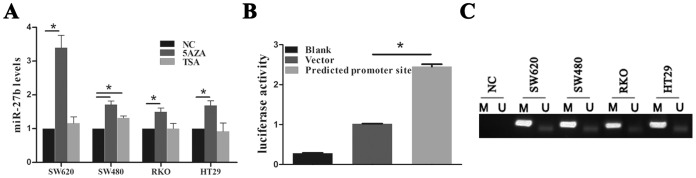
DNA hypermethylation is associated with decreased miR-27b expression.(A) The levels of miR-27b expression in colorectal cancer (CRC) cell lines were determined by qPCR after treatment with 5AZA or TSA for 3 days. (B) Results of luciferase activity assays following transfection with the predicted miR-27b promoter normalized to pRL-TK Renilla luciferase. (C) MSP analysis of the miR-27b CpG island in a set of CRC cell lines. Bands in the ‘M’ lanes are PCR products obtained using methylation-specific primers and those in the ‘U’ lanes are products obtained using unmethylated-specific primers.